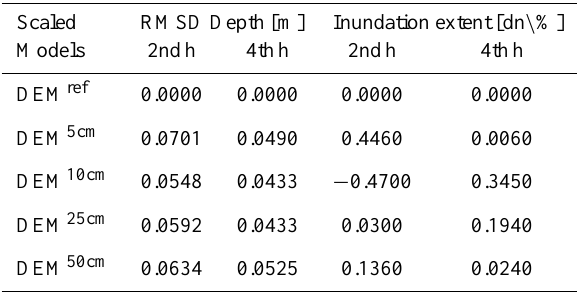
Table 6. Scaling effect upon depth derived results (RMSD) and in- undation extent (differences normalised %) due to subscale param- eterisation for the full area at the 2nd and 4thh of the simulation, ) simulation compared with the reference model (DEM ref 1m